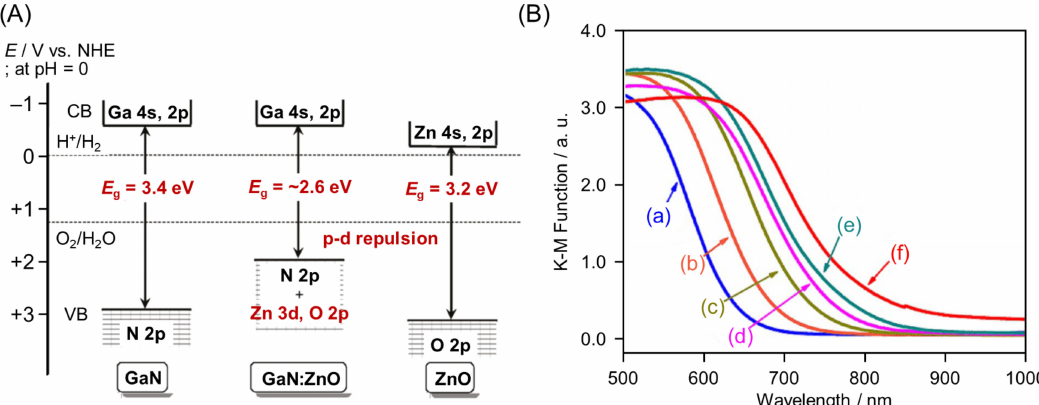
Figure 10. ( A ) Schematic illustration of band structures of GaN, ZnO, and their solid solution. ( B ) Diffuse reflectance spectra for LTCS 1 − x Se x O solid solutions as a function of Se content. Se contents: (a) 0.0, (b) 0.2, (c) 0.4, (d) 0.6, (e) 0.8, and (f) 1.0. Reproduced with permission